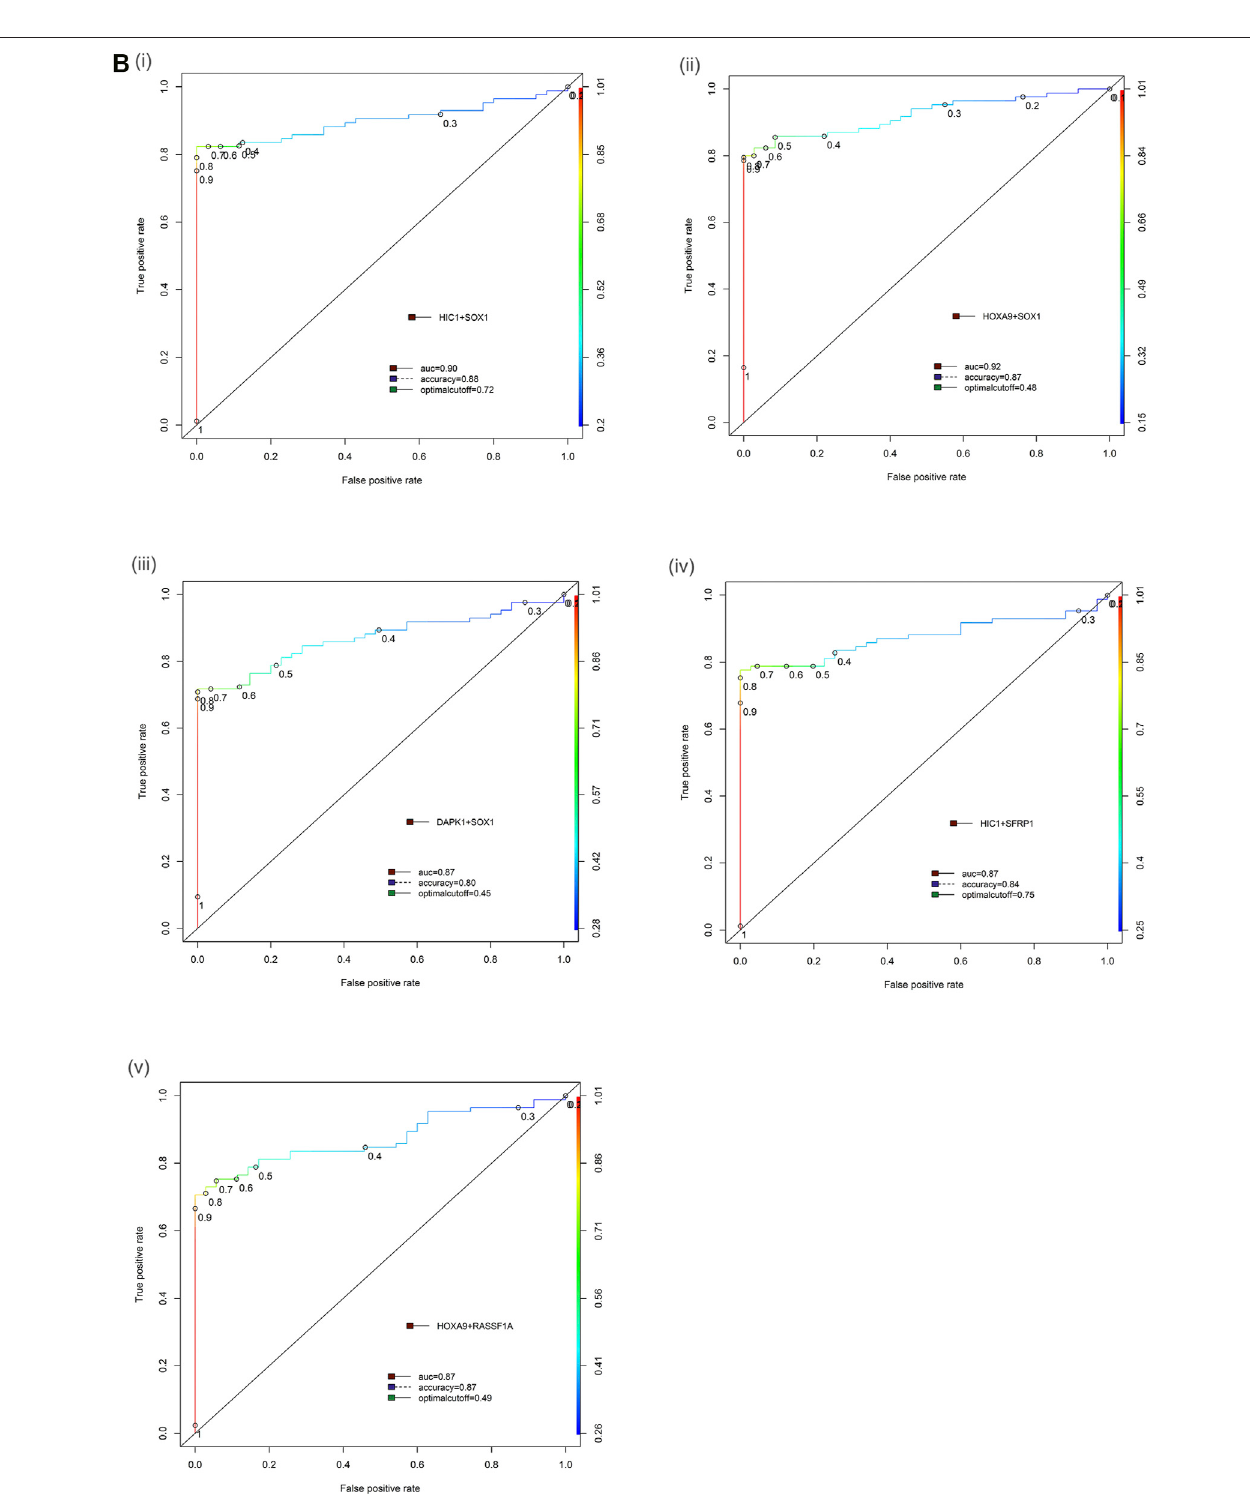
FIGURE 3 | Receiver operator characteristic (ROC) curve differentiating EOC patients from healthy control in tissue samples. The area under the ROCcurve (AUC) suggeststheaccuracyofthebiomarkersindistinguishingovariancarcinomafromnormalhealthycontrolsample,isdepictedforthebiomarkerspanels (Bi) HIC1+SOX1, (ii) HOXA9+SOX1, (iii) DAPK1+SOX1, (iv) HIC1+SFRP1and (v) HOXA9+RASSF1A,respectively.[CombinedtwoDNAmethylationmarkerpanel]whichisbasedonthe sum ofthetwoPMRvalues. AUC: areaunderthecurve.TheROCcurve forbiomarkerpanel HOXA9+HIC1intissuesampleshasbeen previously published (Singh et al.,